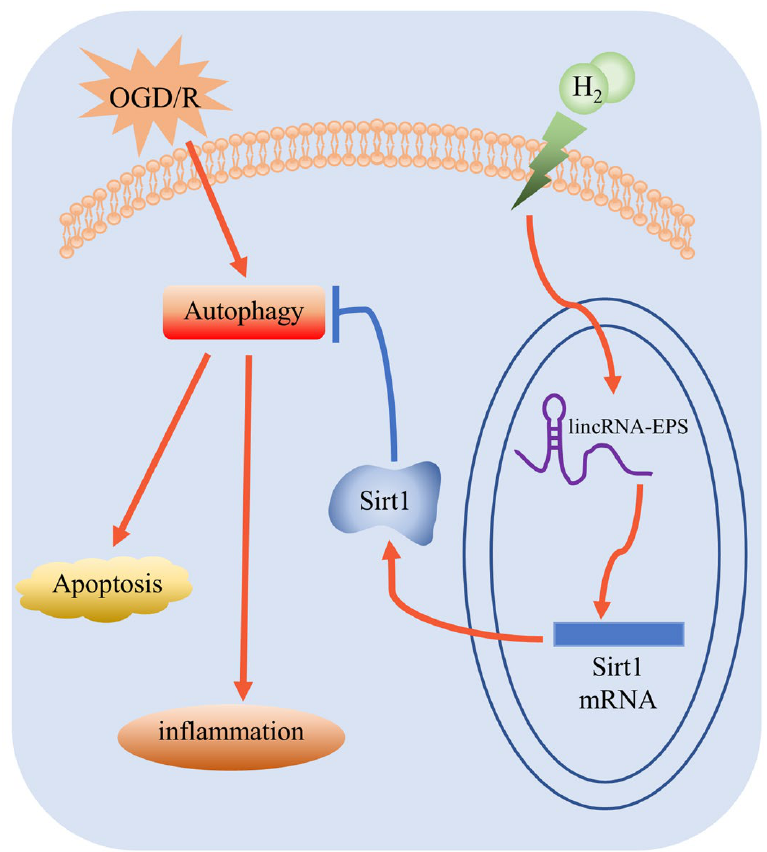
Figure 10. The molecular mechanism of H 2 against OGD/R − induced injury.